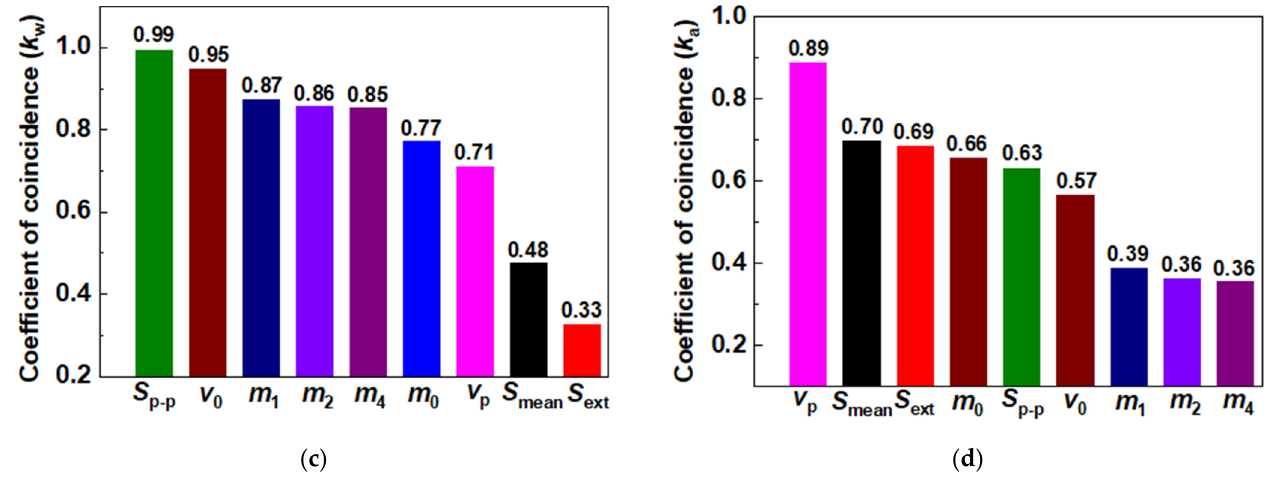
Figure 18. Correlation coefficients between the parameters in kinetics of cellulose degradation ( n w0 , n a0 , k w , k a ) and the characteristic parameters of axial compressive stress on the pressboard ( S ext , S mean , S p-p , m 0 , m 1 , m 2 , m 4 , v 0 , v p ).